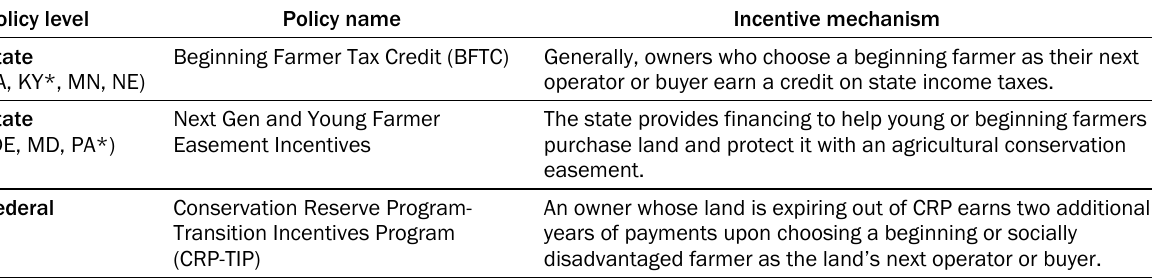
Table 1. Classes of Land Access Policy Incentives